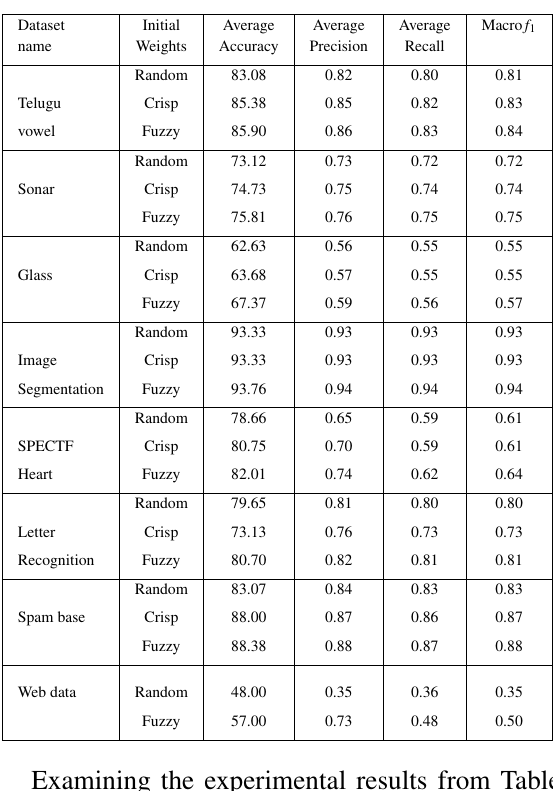
Table 4. Experimental results for NFRGNN.